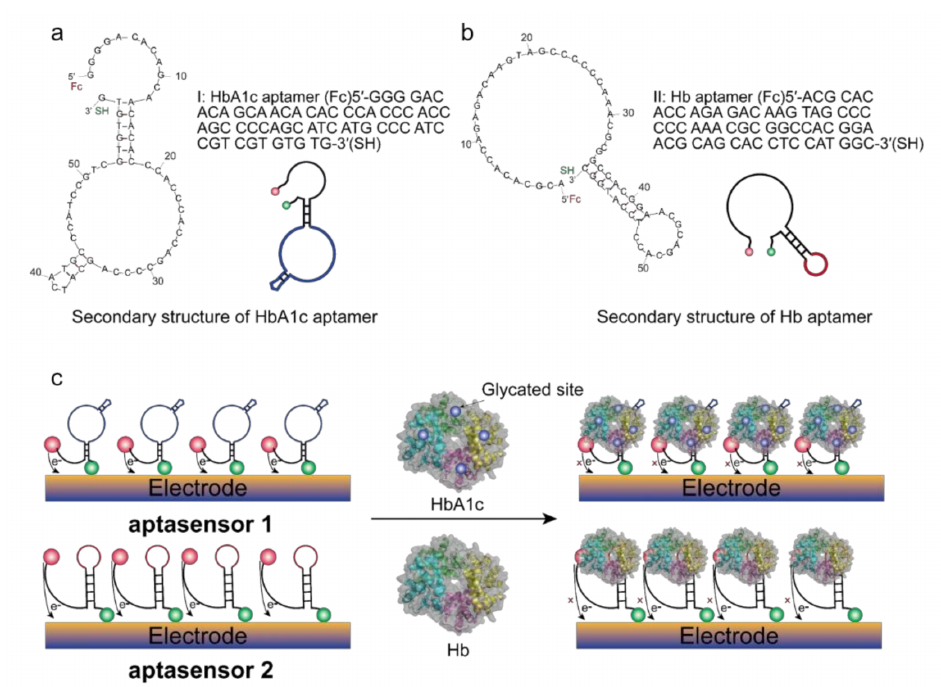
illustration of the construction of aptasensors 1 and 2 through sulfhydryl-gold self-assembly on screen printed electrodes, and the plausible sensing mechanism of the functionalized aptasensors for haemoglobin (Hb) (with aptasensor ( 1 ) and glycated haemoglobin (HbA1c) (with aptasensor ( 2 ); the presence of the proteins increases the distance from the electroactive ferrocene to the electrode surface, thereby impeding the electron transfer